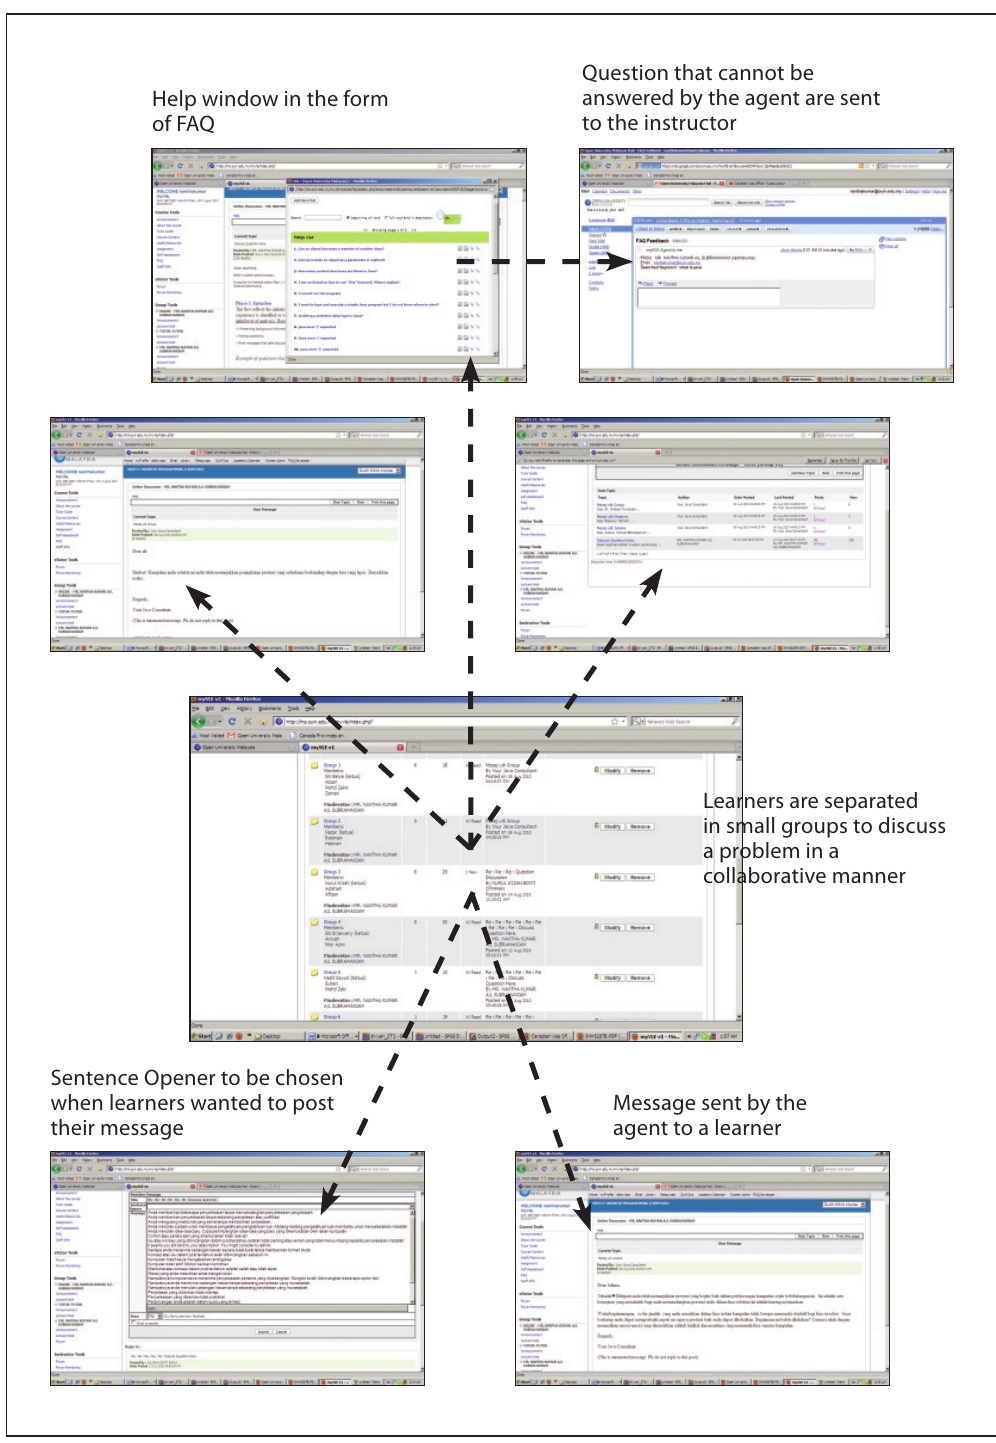
Figure 5 The implementation of the smart